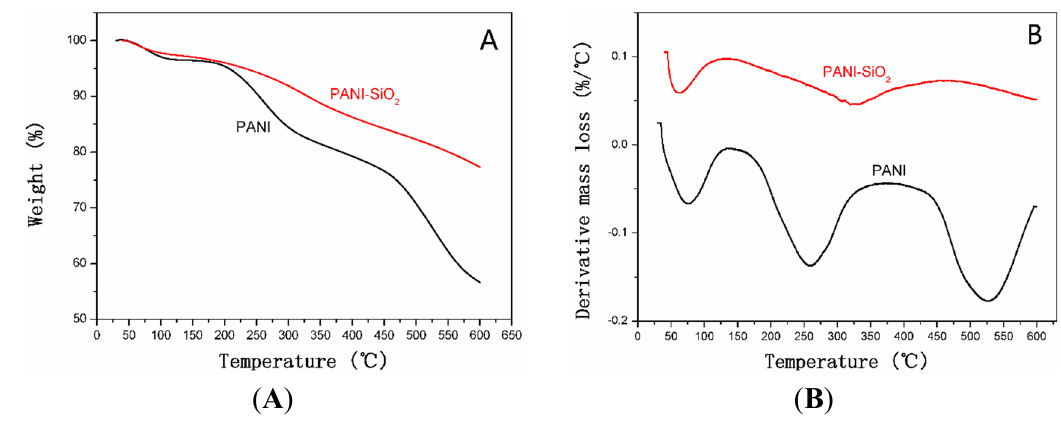
Figure 3. ( A ) TGA curves of bulk PANI and PANI-SiO 2 . ( B ) DTG curves of bulk PANI and PANI-silica.